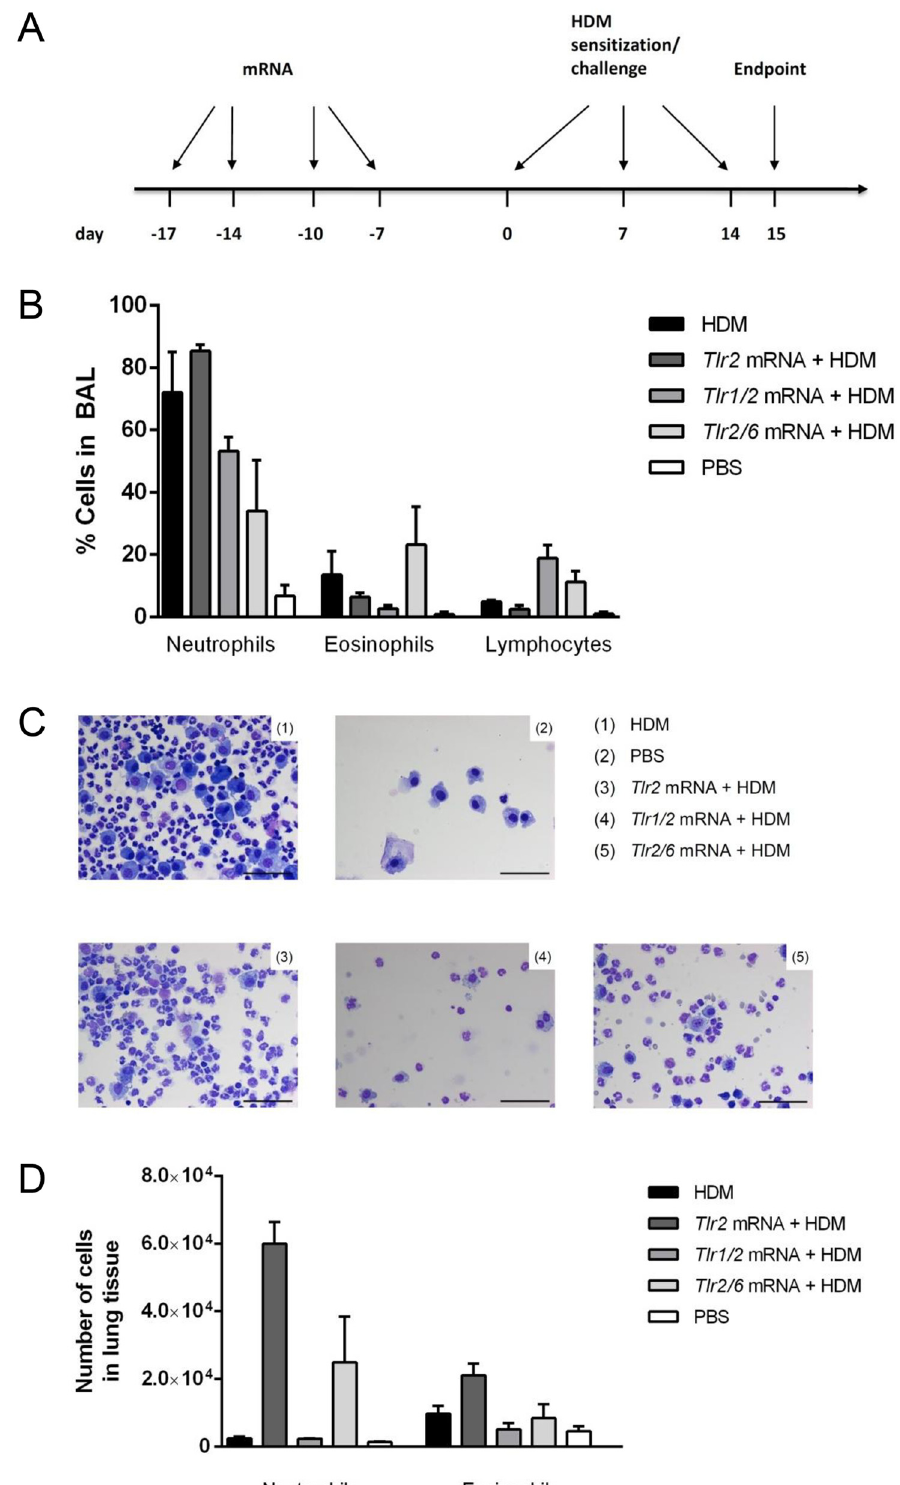
Fig 1. Inflammatory cells in BALF and lung tissue. (A) Mice were treated according to the injection schedule for the HDM-induced asthma model. (B) BALF was centrifuged and cells were analyzed via differential cell count. Differences remained non-significant. Data are presented as mean ± SEM; n = 3.